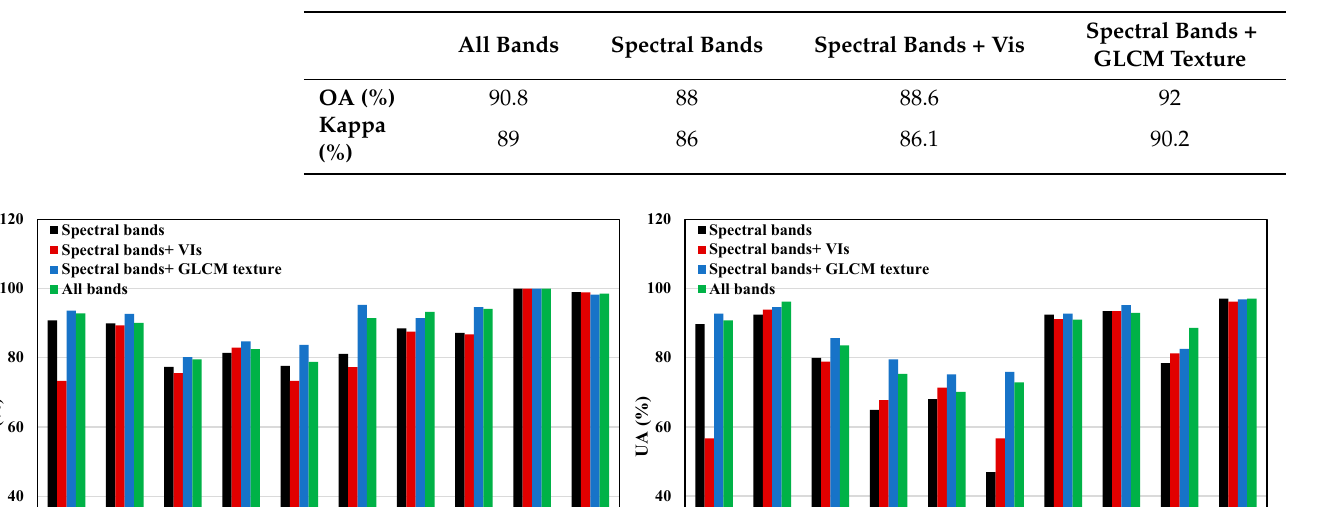
11 of 21 Figure 5. Band importance ranking based on: ( a ) mean decrease accuracy and ( b ) mean decrease Gini. The methodology was applied to different independent variables input to analyze the importance of the GLCM textures. The classification was repeated for three additional scenarios of input bands: (I) only S2A spectral bands, (II) S2A spectral bands and VIs, and (III) S2A spectral bands and GLCM textures. The RF classifier based on the S2A spectral band and GLCM texture achieved the maximum OA and kappa, as presented in Table 5. Using all 26 variables ranked second with a difference of 1.2%, lower than the combination of spectral bands and GLCM textures. The minimum OA and kappa also were obtained for employing only S2A spectral bands. Adding GLCM texture to S2A spectral bands in- creased the accuracy metrics by 4%. These findings demonstrate the importance of GLCM texture features for improving the predictability of the RF classifier [51]. The inclusion of GLCM textures features affects the OA and enhances class separability. They enable more